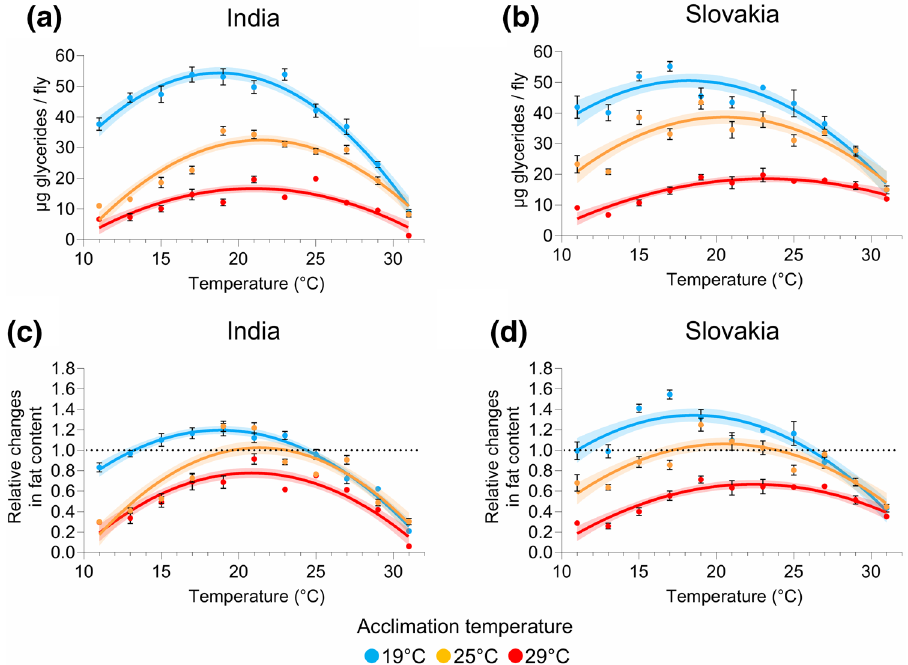
Figure 1. Acclimation temperature affects thermal reaction norms for fat reserves. ( a , b ) Absolute fat content (µg glycerides per fly) in flies from India ( a ) and Slovakia ( b ). ( c , d ) Relative changes in the absolute fat content (calculated as a ratio between the final values and the mean of initial values) in flies from India ( c ) and Slovakia ( d ). Data points are mean values ± s.e.m.. Lines represent a quadratic fit to data with the 95% confidence band. For statistical analyses, see Supplementary Tables S1, S2, S5.